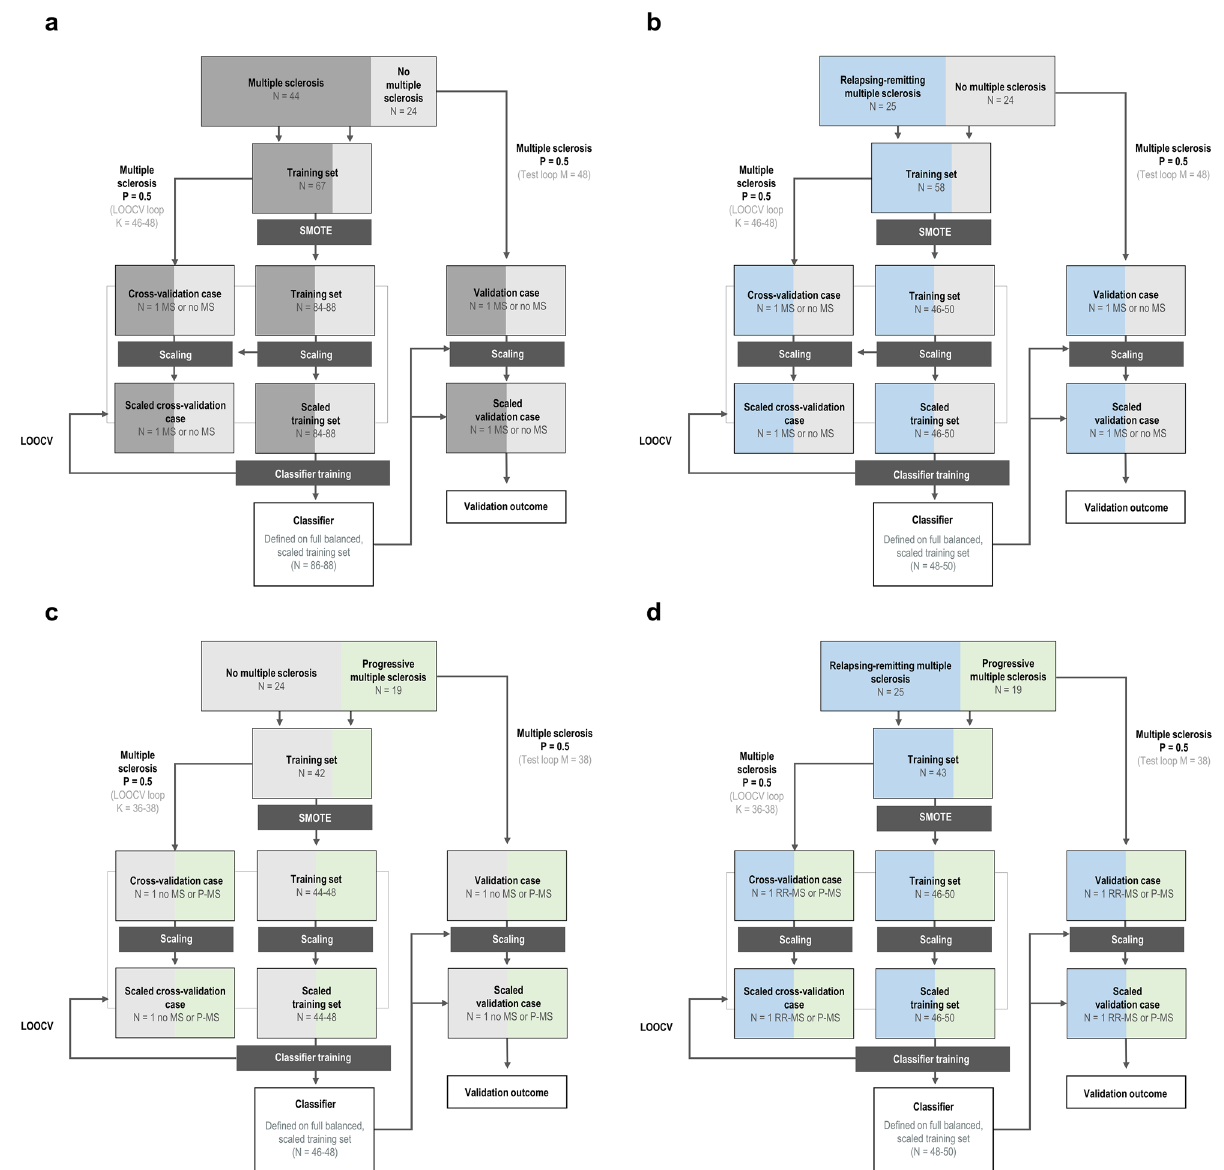
Figure 2. Training, optimization, and validation pipeline for multivariate classifiers of multiple sclerosis state and type by frontal cortex metabolite profiles. Classification pipelines constituted two binary decisions: The first ( A ) established the presence of multiple sclerosis, while the second ( D ) characterized the phenotype. Models distinguishing from control relapsing–remitting multiple sclerosis ( B ) and progressive multiple sclerosis ( C ) were also implemented for context in interpreting performance differences between ( A ) and ( D ). One data set at a time was held out for use as the validation set, yielding a total of N 1 × 2 runs for data with smaller group size N 1 . Undersampling proceeded similarly for an inner cross-validation loop used for hyperparameter optimization and feature selection, in that each of the training cases was removed once for use as a cross- validation set for that training run, with a total of N 2 × 2 cross-validations for data with the smaller training group size